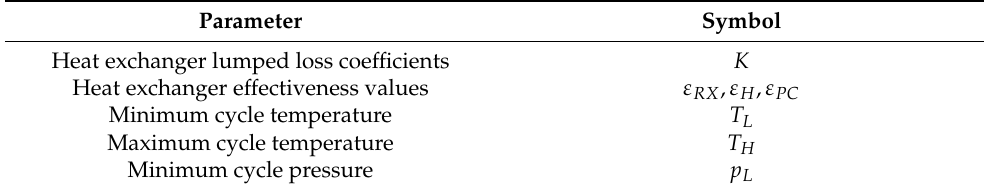
Table 2. Input feature parameters for the recuperated Brayton cycle.